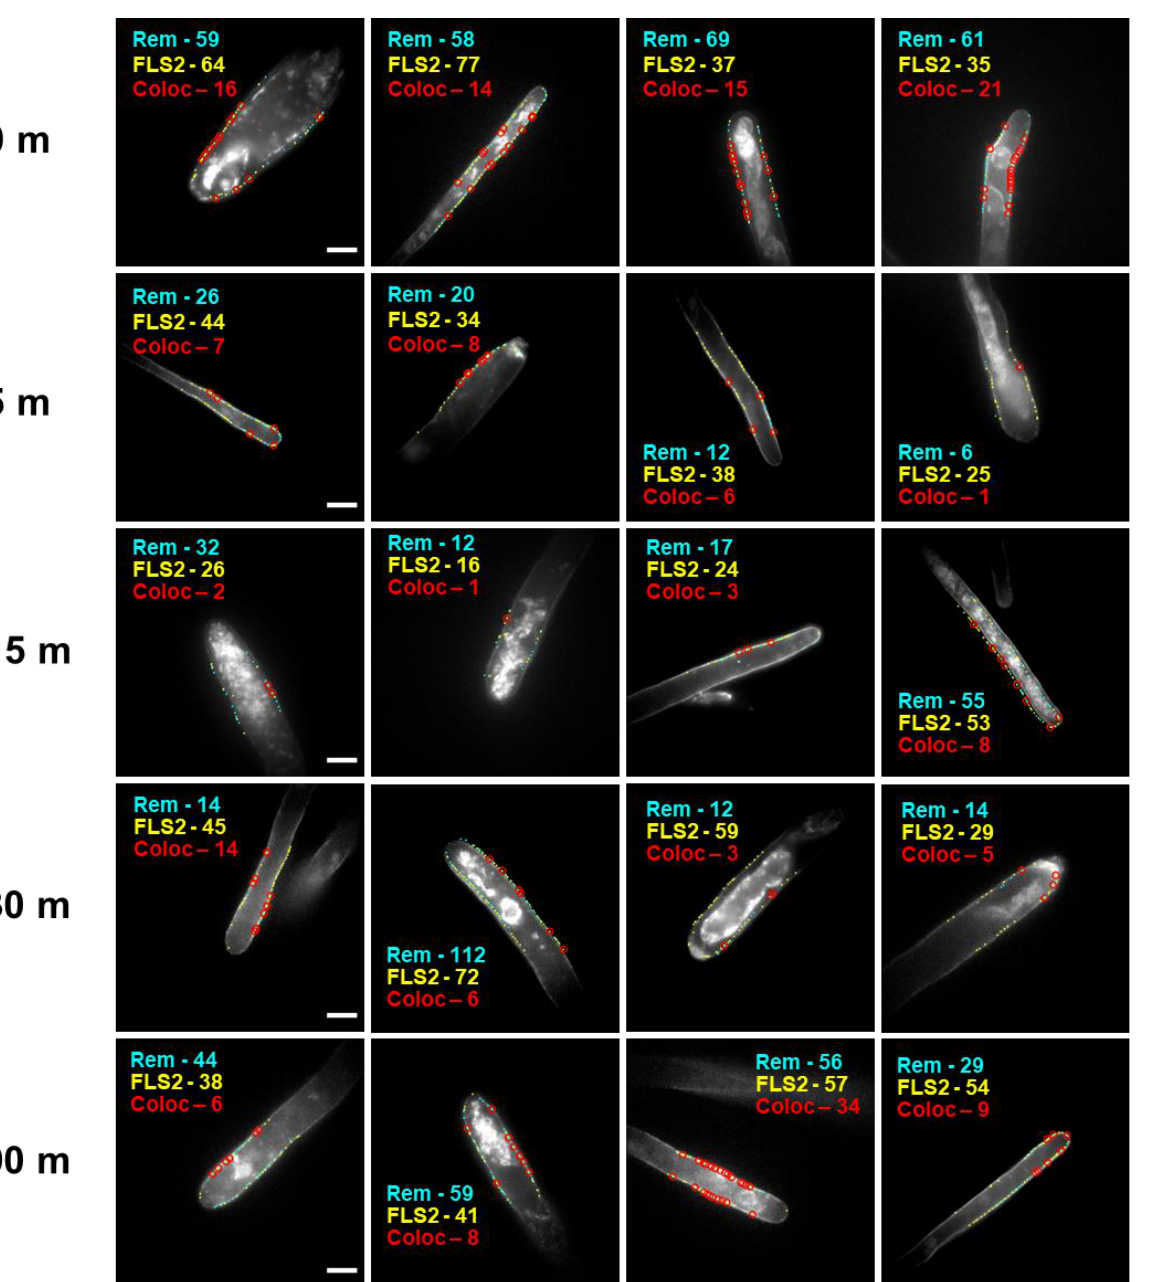
Figure 1. Representative super-resolution images of A. thaliana root hairs stimulated with 200 nM flg22 for a set length of time and then fixed, indicating localization of remorin (cyan), FLS2 (yellow), and colocalized remorin-FLS2 pairs within 100 nm (red circles). The scale bars indicate 10 µm. Note the steady drop in receptor density over time, which is largely restored within 90 min.